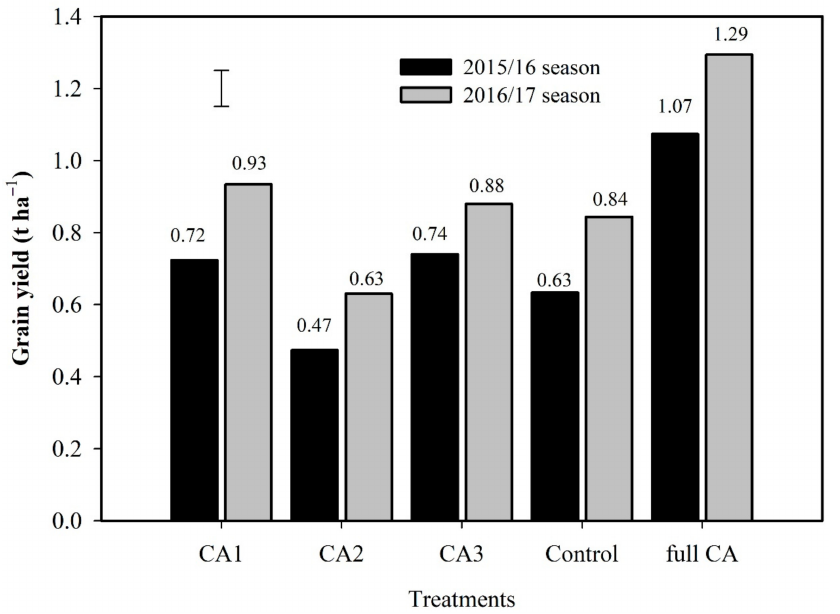
Figure 6. Finger millet grain yield with conventional tillage only (control), conventional tillage + mulch (partial CA1), reduced tillage only (partial CA2), reduced tillage + mulch (partial CA3) and reduced tillage + mulch + intercropping with cowpea (full CA) treatments during 2015/16 and 2016/17 cropping seasons. Error bar represents LSD 0.05 .